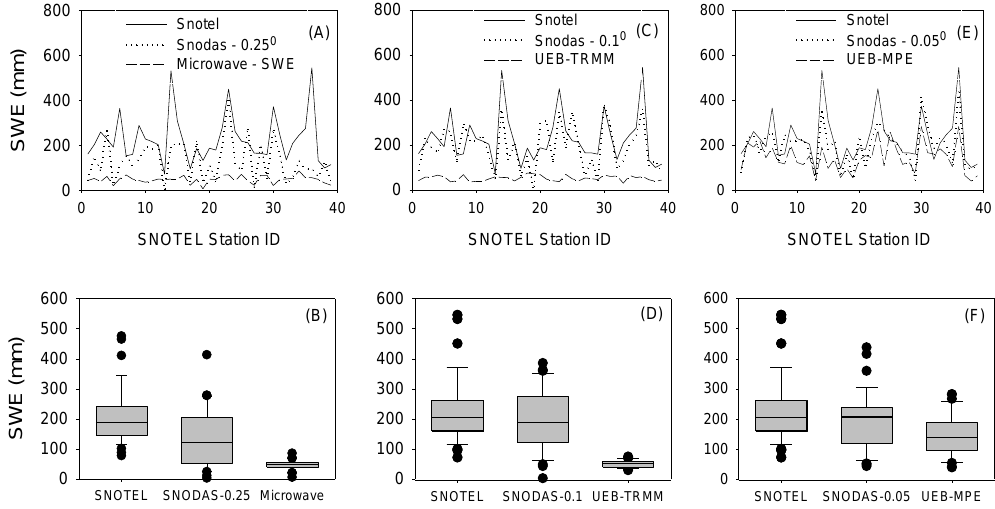
Fig. 7. Average SWE from SNOTEL and SNODAS for the winter and spring months compared with SWE estimated from (A) MI, (C) SWE predicted with UEB when driven with TRMM precipitation, and (E) UEB forced with MPE precipitation. The SWE simulated with the UEB is for the period January 2006–April 2008, excluding the months from June to November. (B, D, F) are box plots of the data in the first three graphs.